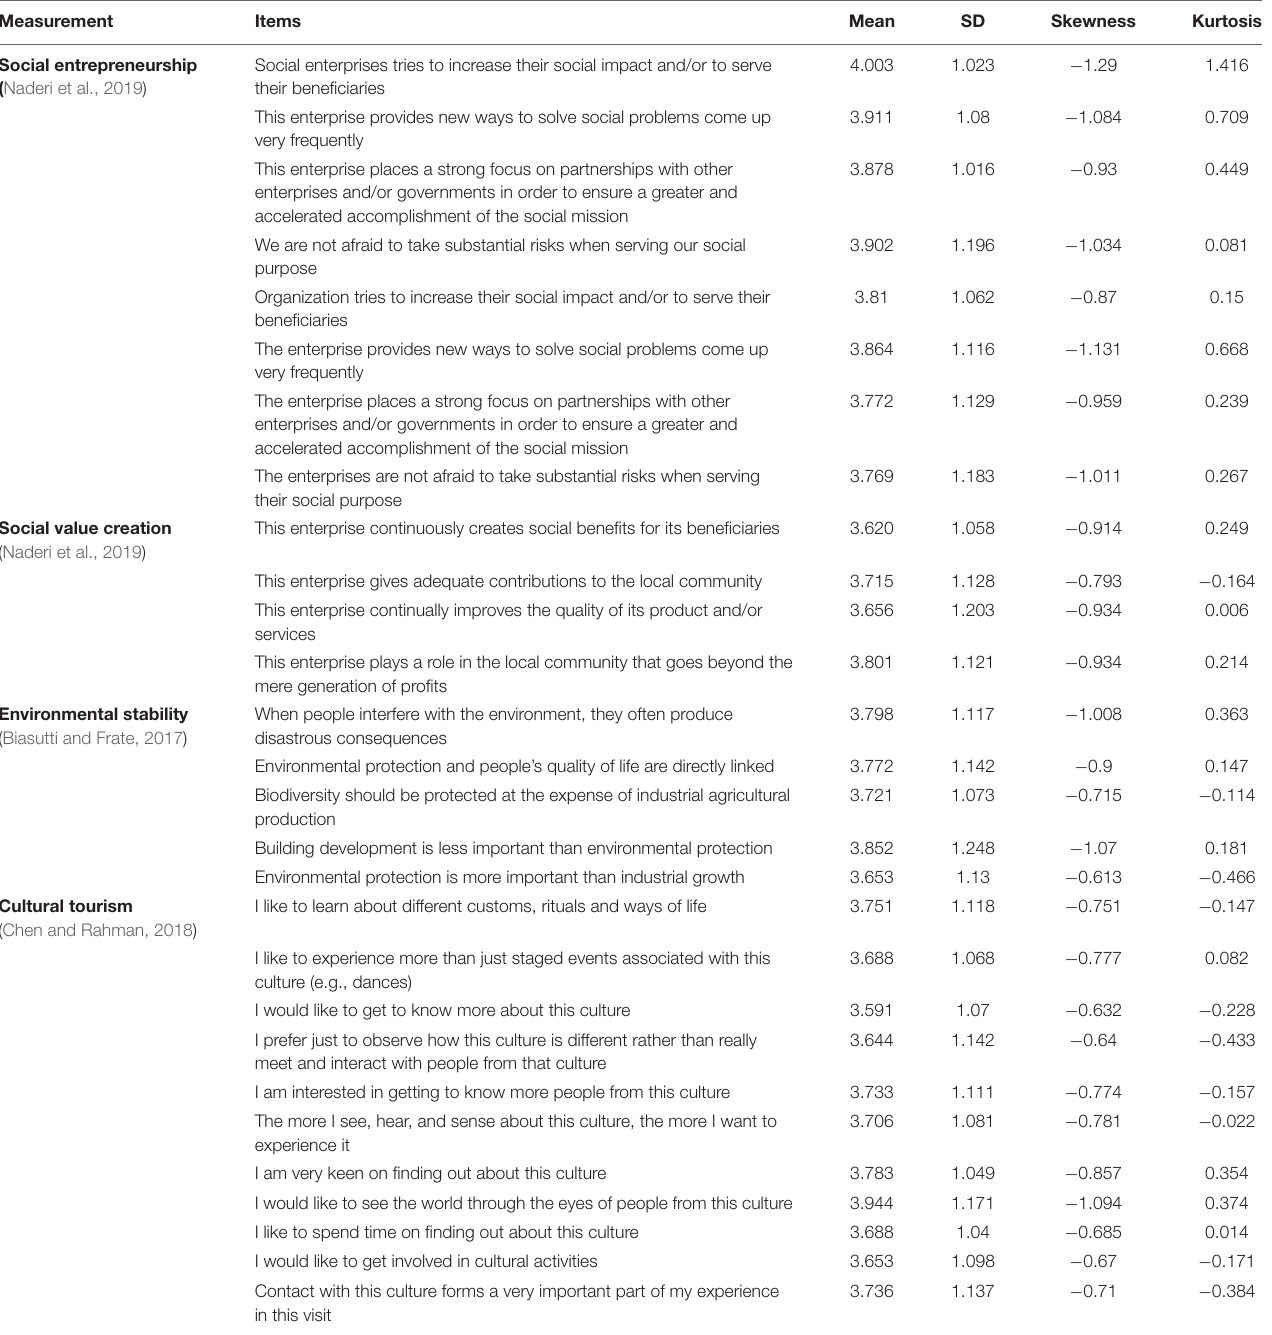
TABLE 2 | Measurement, items, and descriptive